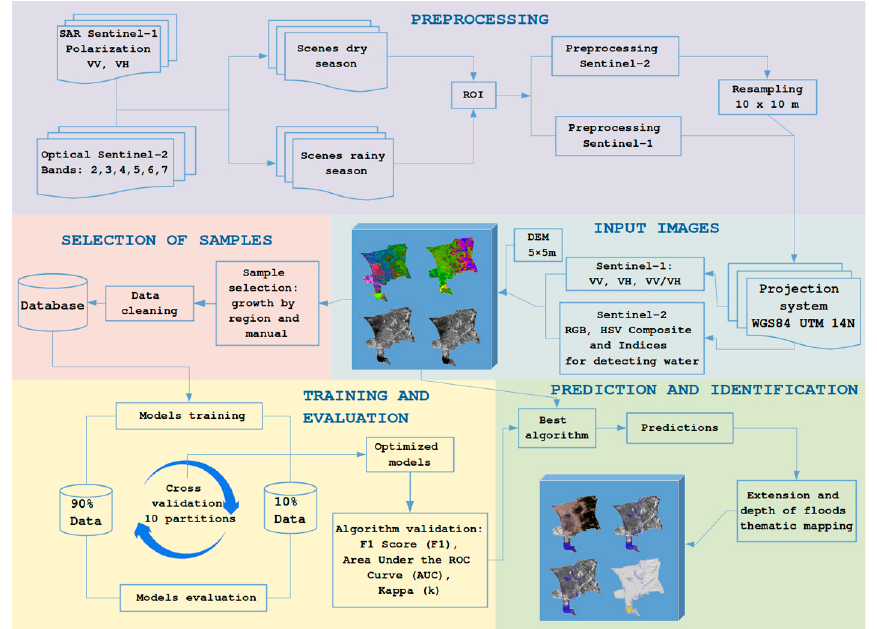
Figure 2. Workflow for preprocessing, sample selection, training, evaluation of machine learning algorithms, and generation of thematic maps.